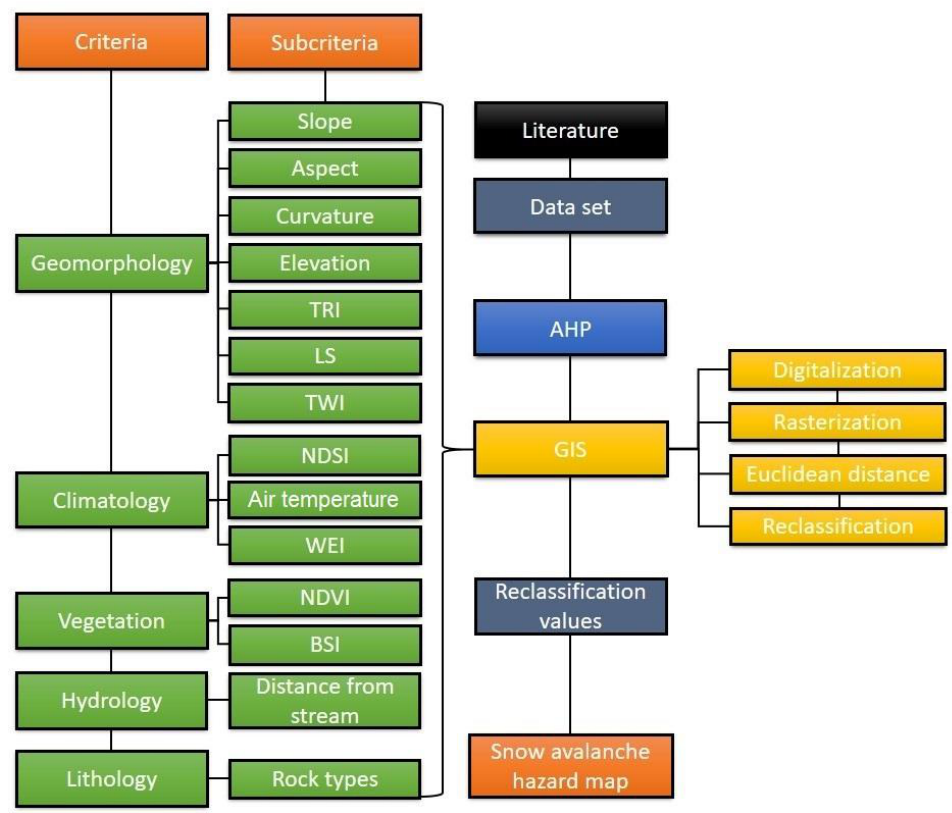
Figure 4. Flow chart with all the procedures and methods used in this research.